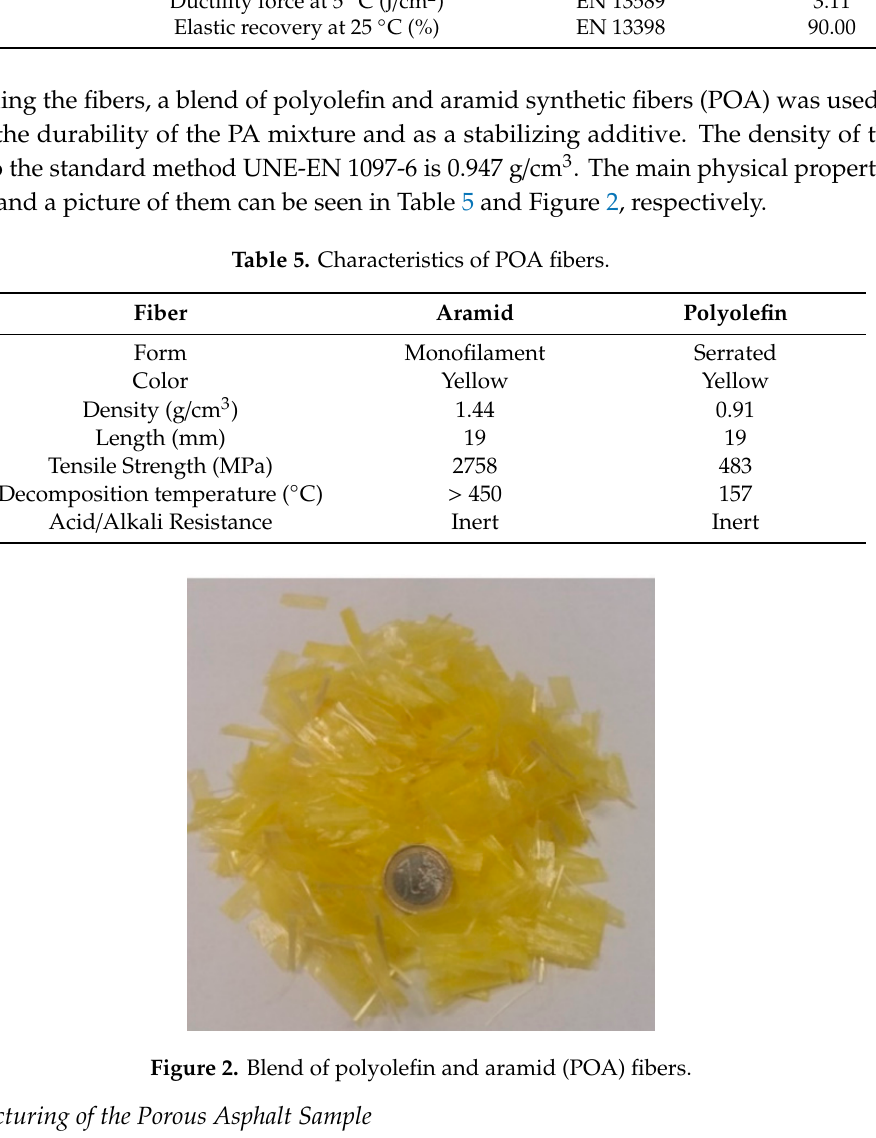
Table 4. Main properties of the binders used.